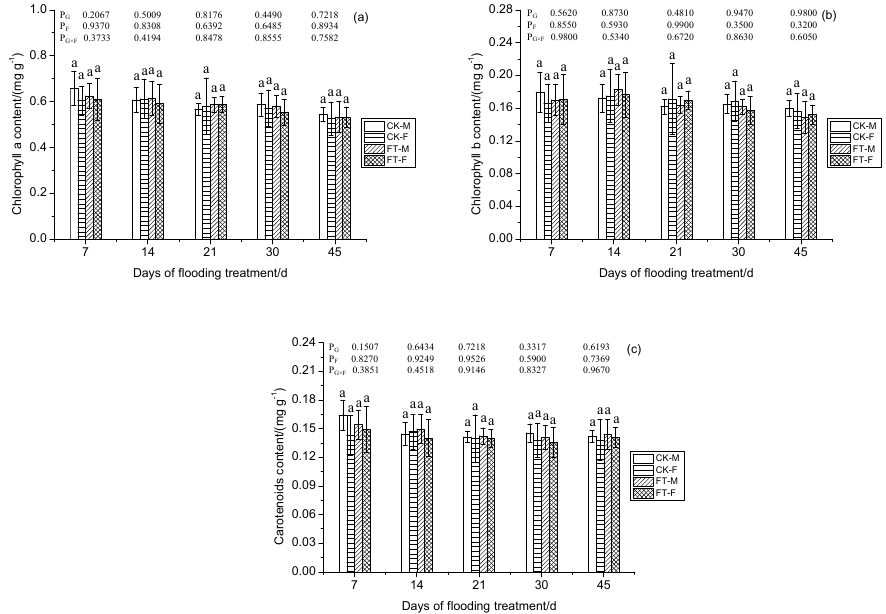
Figure 5. Chlorophyll a (Chl a) ( a ), Chlorophyll b (Chl b) ( b ), and Carotenoids (Car) ( c ) contents of male vs. female Salix viminalis plants at different times of flooding treatment.